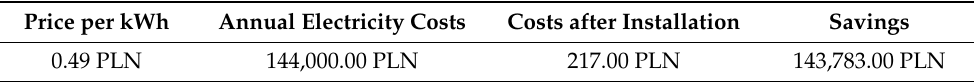
Table 12. Annual savings in electricity costs after the completion of the project. Source: designed by authors using the information obtained from the enterprise.